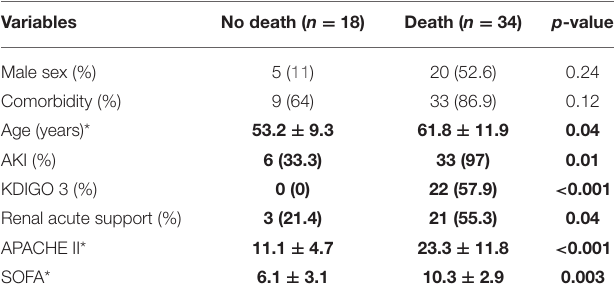
TABLE 5 | Clinical and laboratory characteristics in patients admitted in ICU according to outcome. Variables